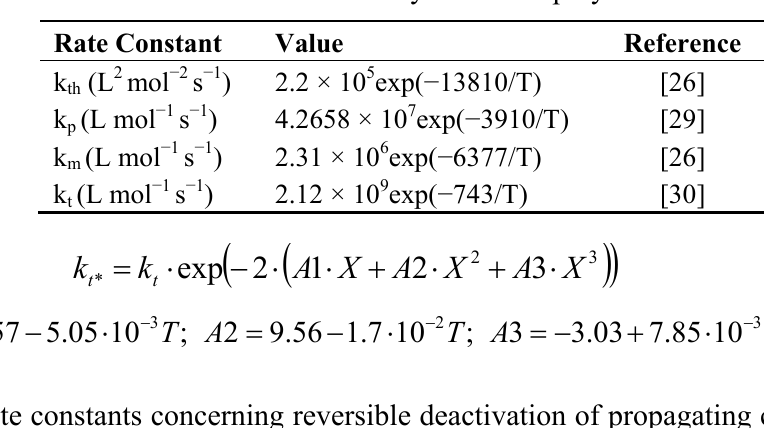
Table 4. Rate constants of styrene homopolymerization.